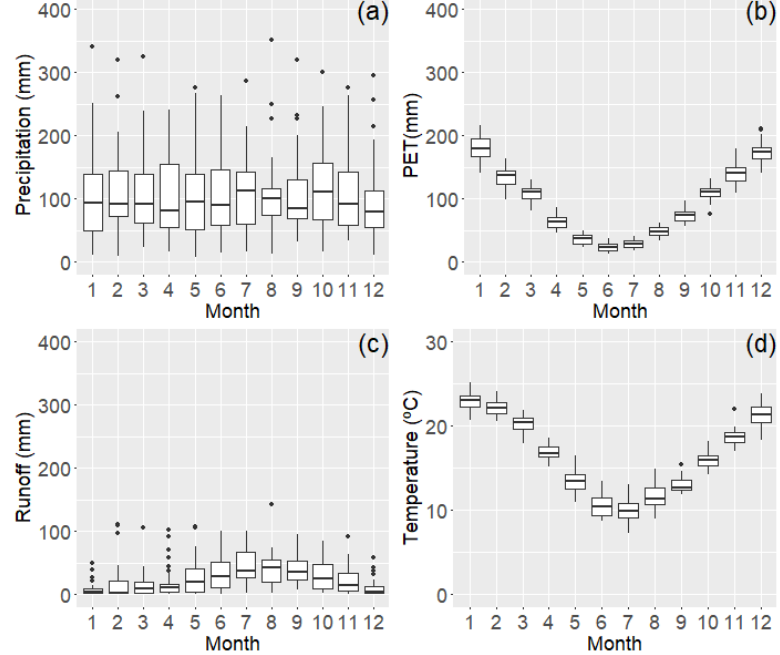
Figure 3. ( a ) Boxplot of monthly precipitation, ( b ) potential evapotranspiration, ( c ) runoff at Paso de los Troncos, and ( d ) mean temperature for the period 1981–2016.